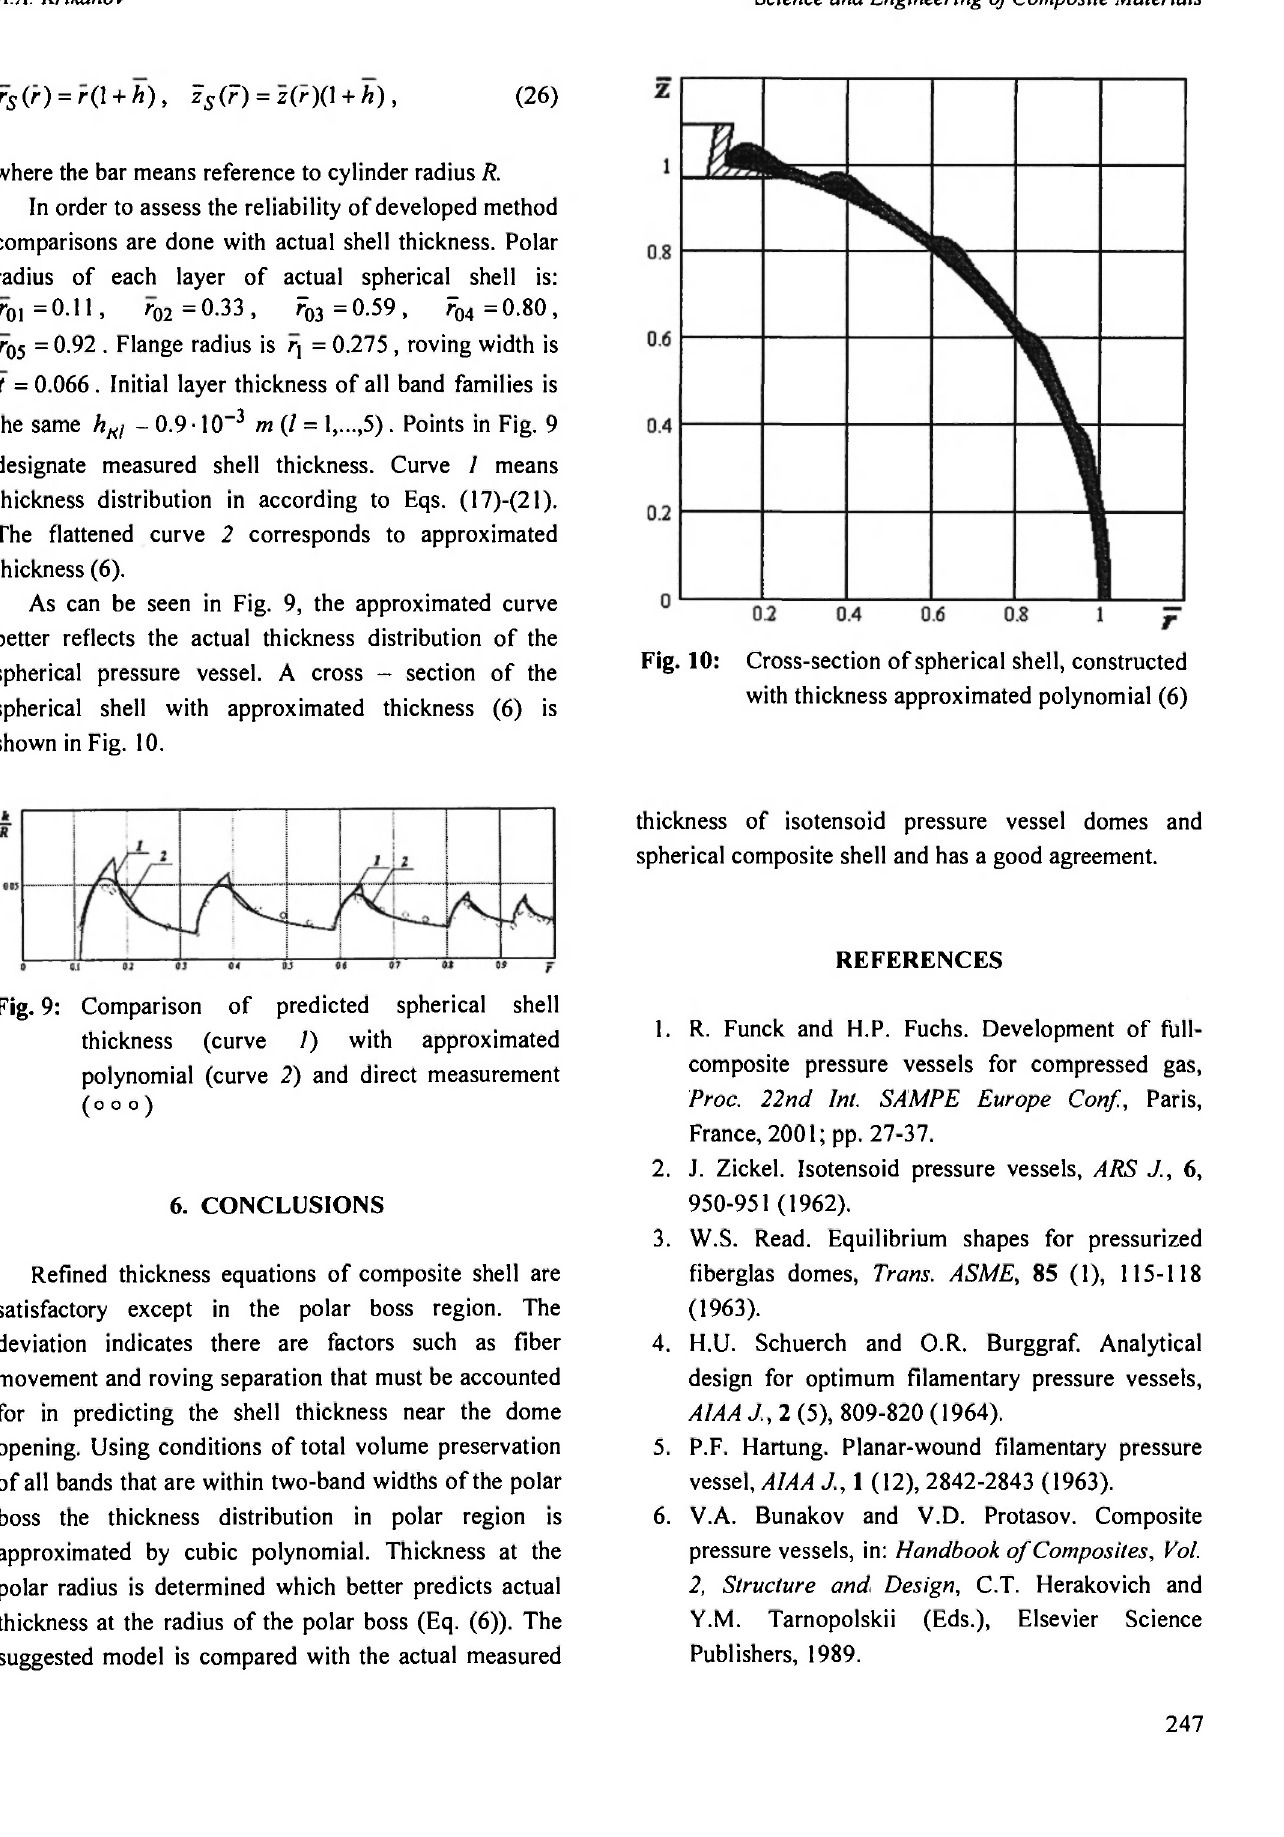
Fig. 10: Cross-section of spherical shell, constructed with thickness approximated polynomial (6)